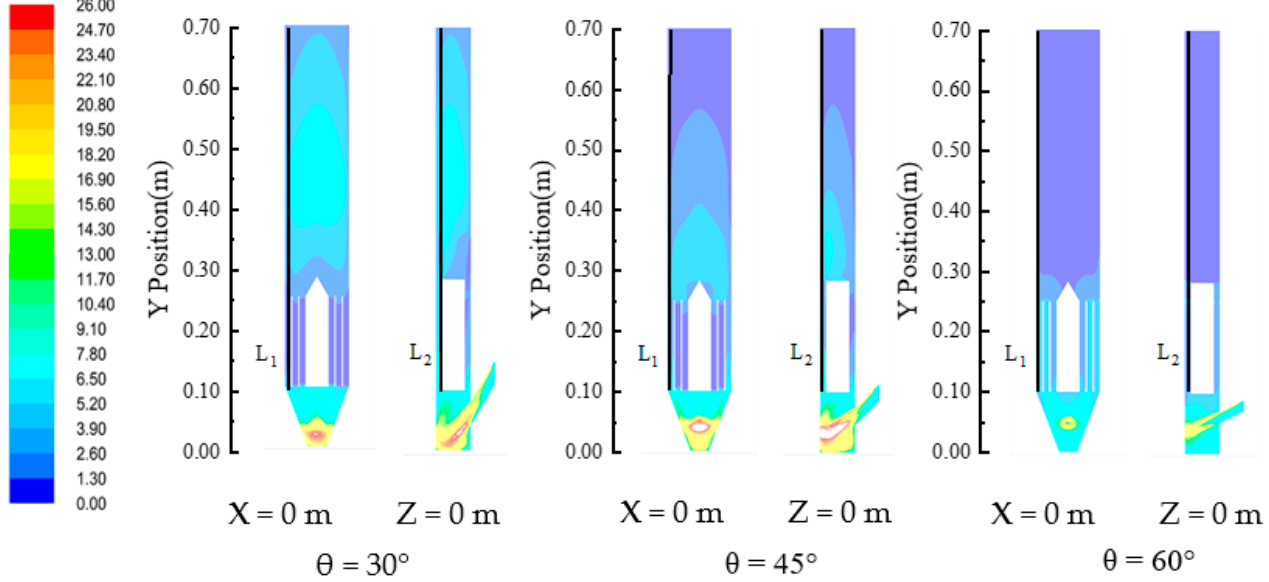
Figure 8. Distribution of turbulence intensities across different sections of the observation trough corresponding to different inlet angles.